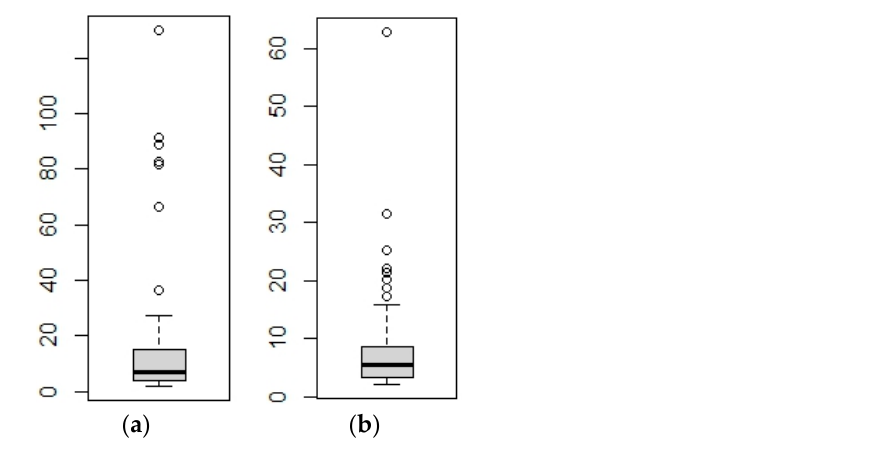
Figure 6. Boxplots of the patch size (ha) of ( a ) TDF loss patches and ( b ) TDF gain